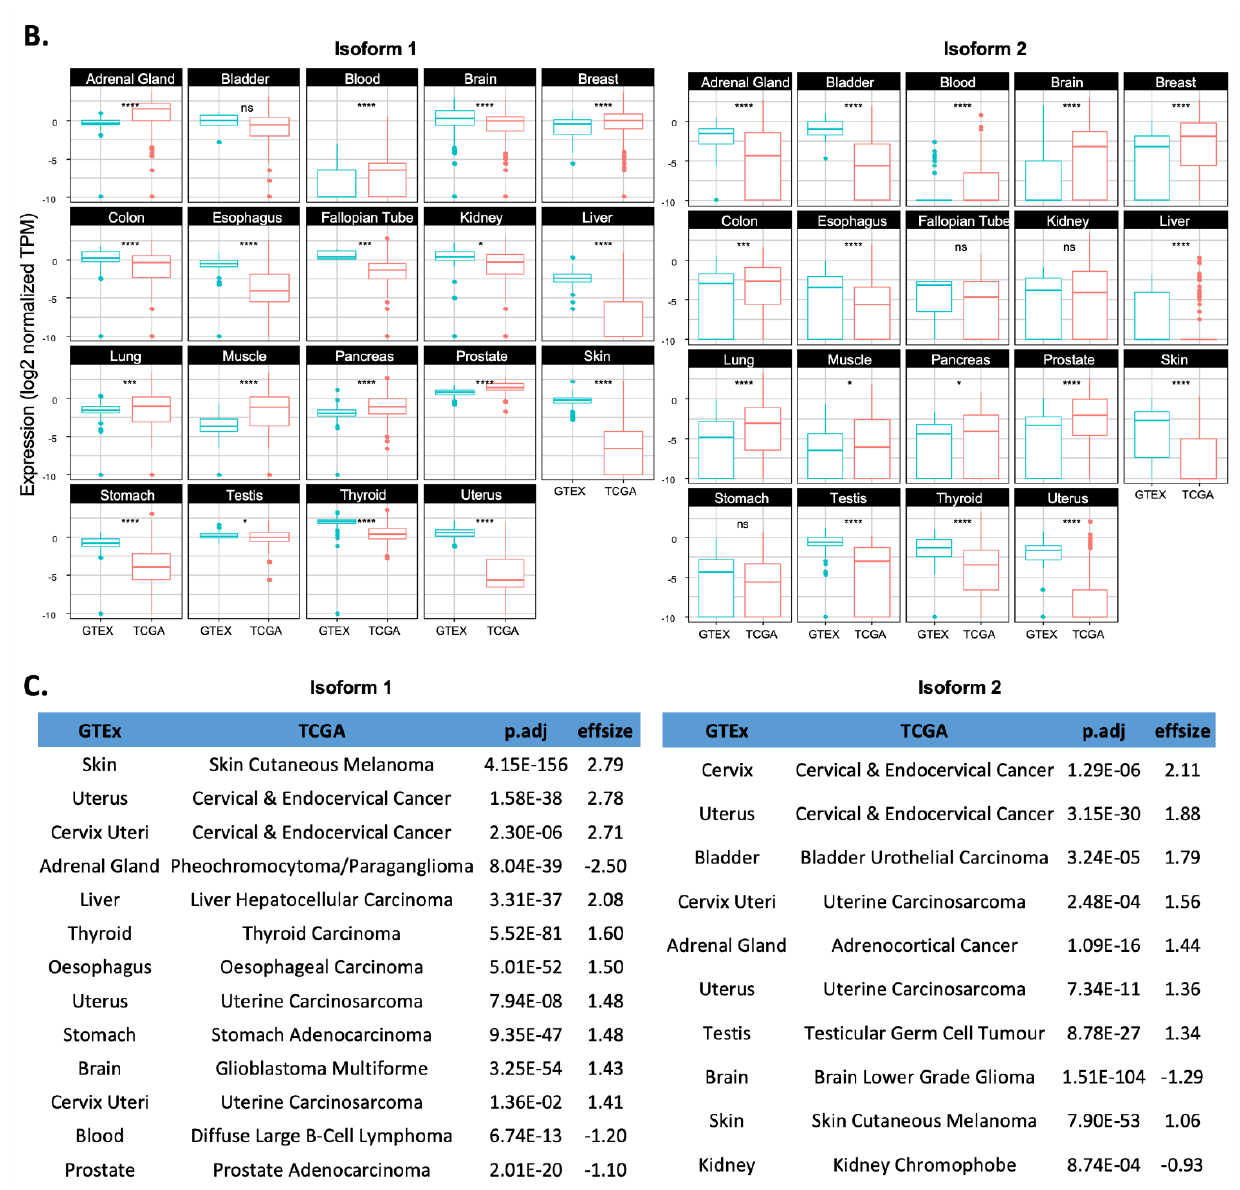
Figure 2. Comparison of RSK4 isoform expression between normal tissues (GTEx) and tumour samples (TCGA). ( A ) Comparison of overall isoform 1 and 2 expressions between normal and cancer samples. ( B ) Comparison of isoform 1 and 2 expressions between individual normal tissues and cor- responding cancer types. Stats: Wilcoxon tests were used with * = p.adj < 0.05; *** = p.adj < 1 × 10 − 3 ; **** = p.adj < 1 × 10 − 4 ; ns = not significant. ( C ) Comparison of RSK4 isoform 1 (left) and 2 (right) expression between normal and corresponding cancerous tissues is shown for cases with large ef- fect size (>0.5), as determined by Cohen’s test. Adjusted p -values are from Dunn’s test with effect size